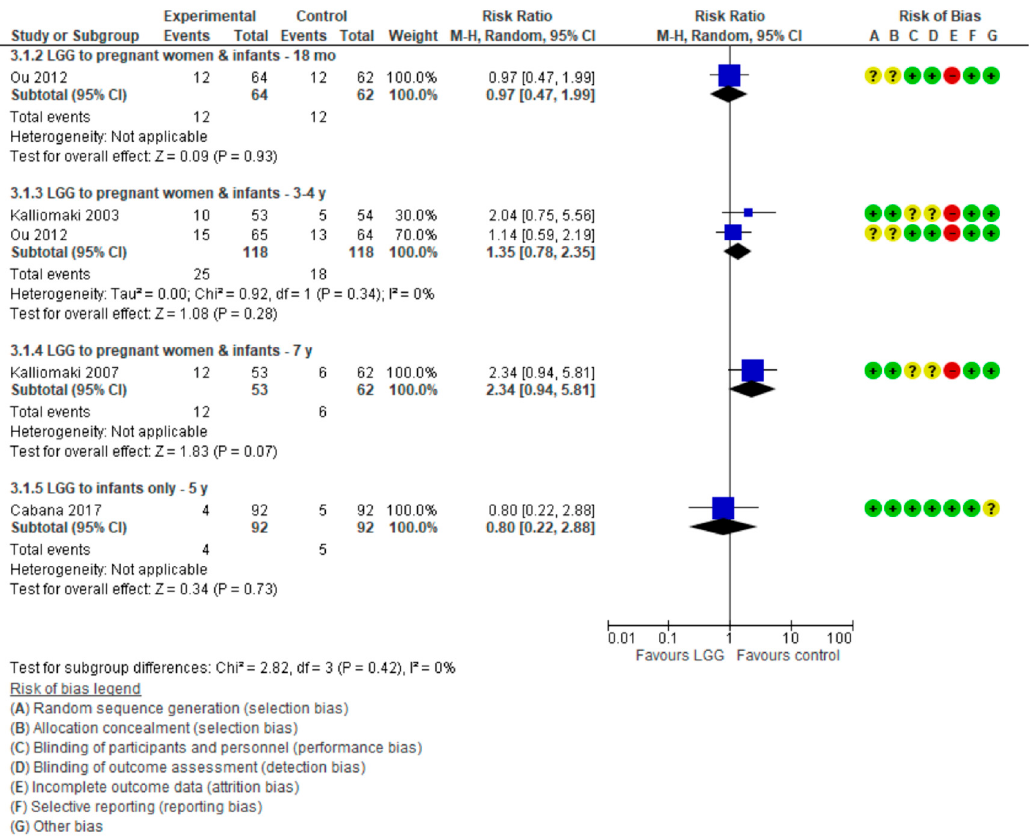
Figure 5. Secondary outcome: Effect of LGG supplementation on allergic rhinitis (data presented based on the timing of LGG administration and the timing of assessment).